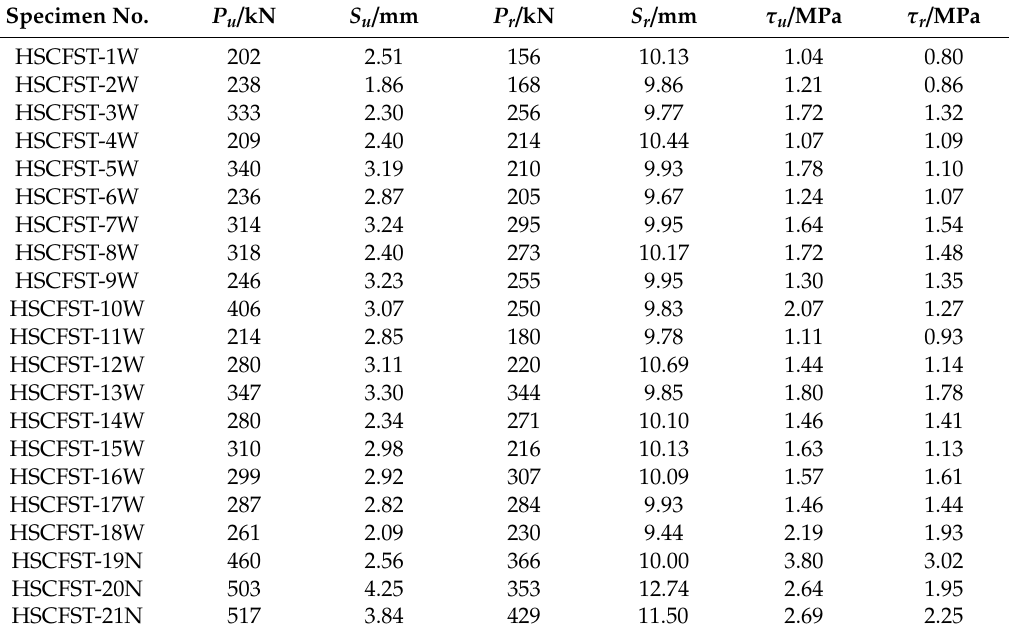
Table 7. Characteristic values of test